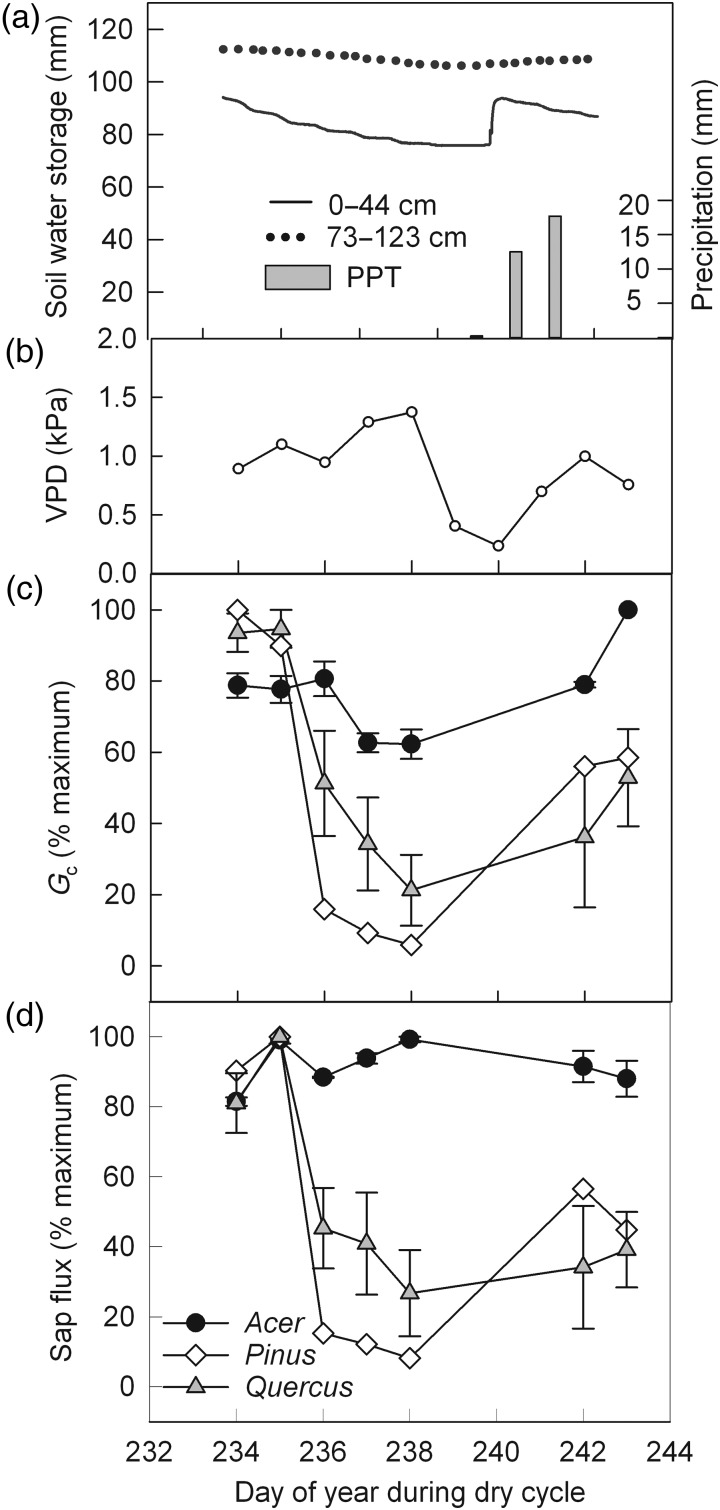
(a) Soil moisture depletion and precipitation during a soil drying and rewetting cycle for one hillslope site in August 2009. Total soil water from 0 to 44 cm (closed circles) and 73–123 cm (open circles) is shown. Values were weighted by midpoint between sensor depths. (b) Daytime (7 am to 7 pm) VPD in kPa for the dry week and recovery, with values <0.1 kPa omitted. (c) Crown conductance (Gc,% maximum) based on sap flux and VPD for Acer, Quercus and Pinus individuals at the south ridge site during the same soil drying and rewetting cycle. (d) Sap flux (% maximum) for individuals at the south ridge site. For (c) and (d), values for individuals of each genus, Quercus (n = 3) and Acer (n = 2) are shown with bars representing standard errors of the mean (Pinus, n = 1). Average values for crown conductance and sap flux were normalized by the percentage of maximum over the dry cycle and recovery. Day of year 239, 240 and 241 were omitted due to precipitation events.